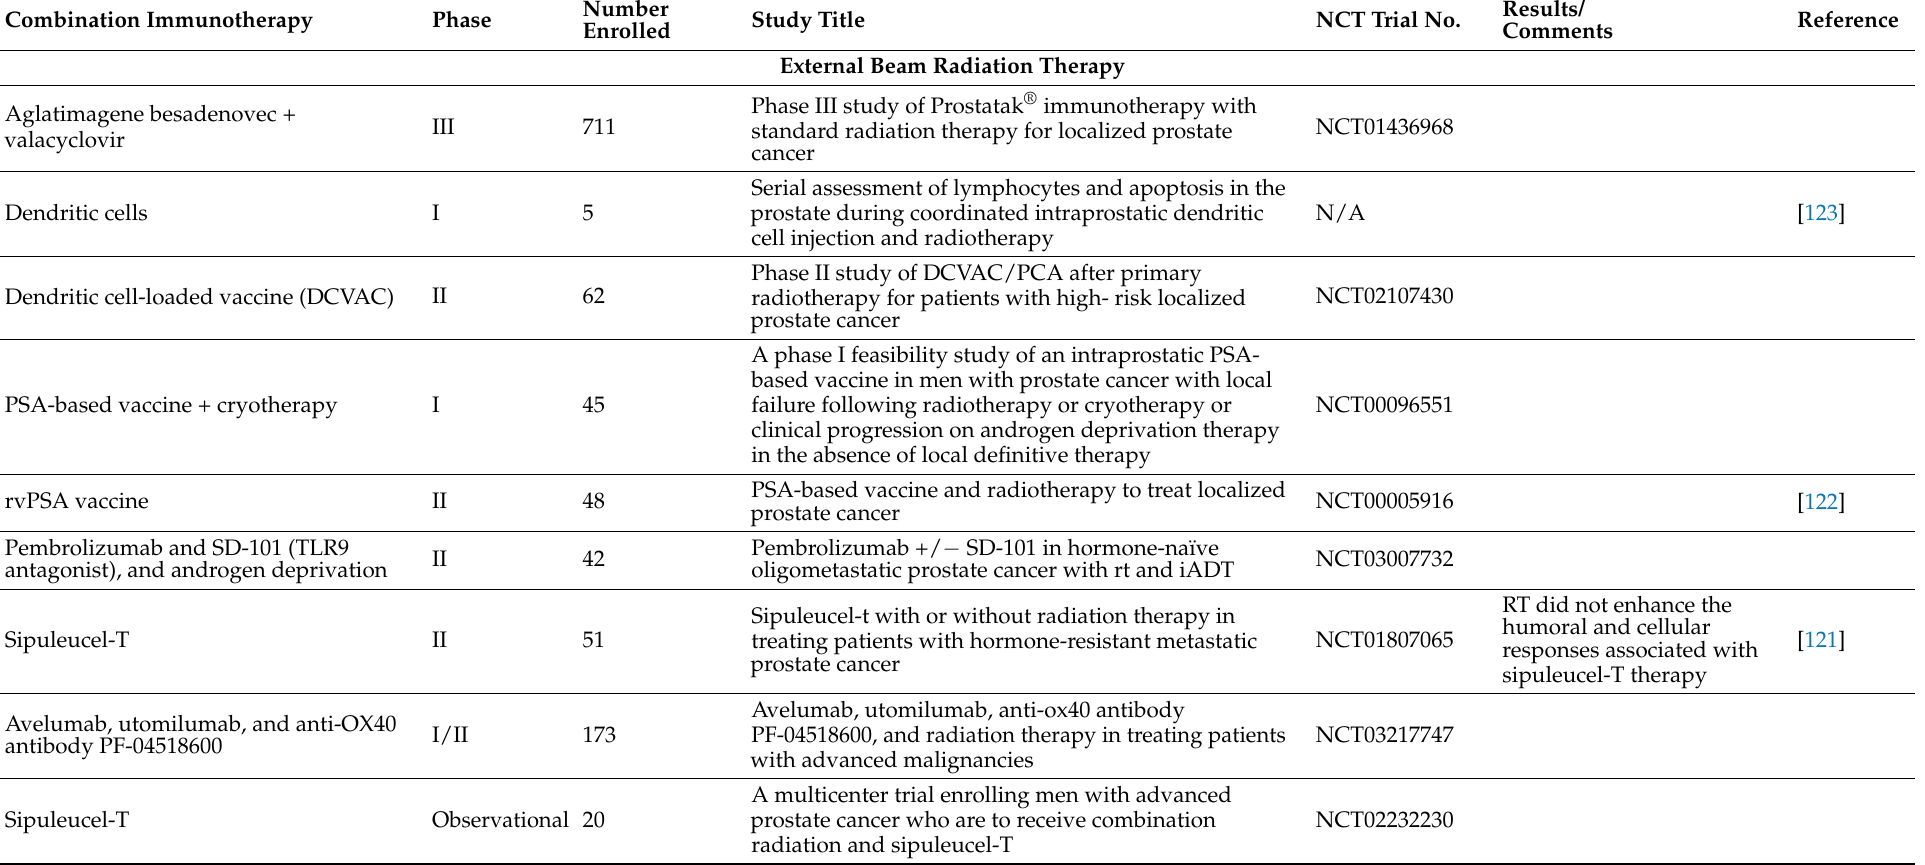
Table 2. Clinical trials using targeted radiation therapy in combination with immune-based treatments for prostate